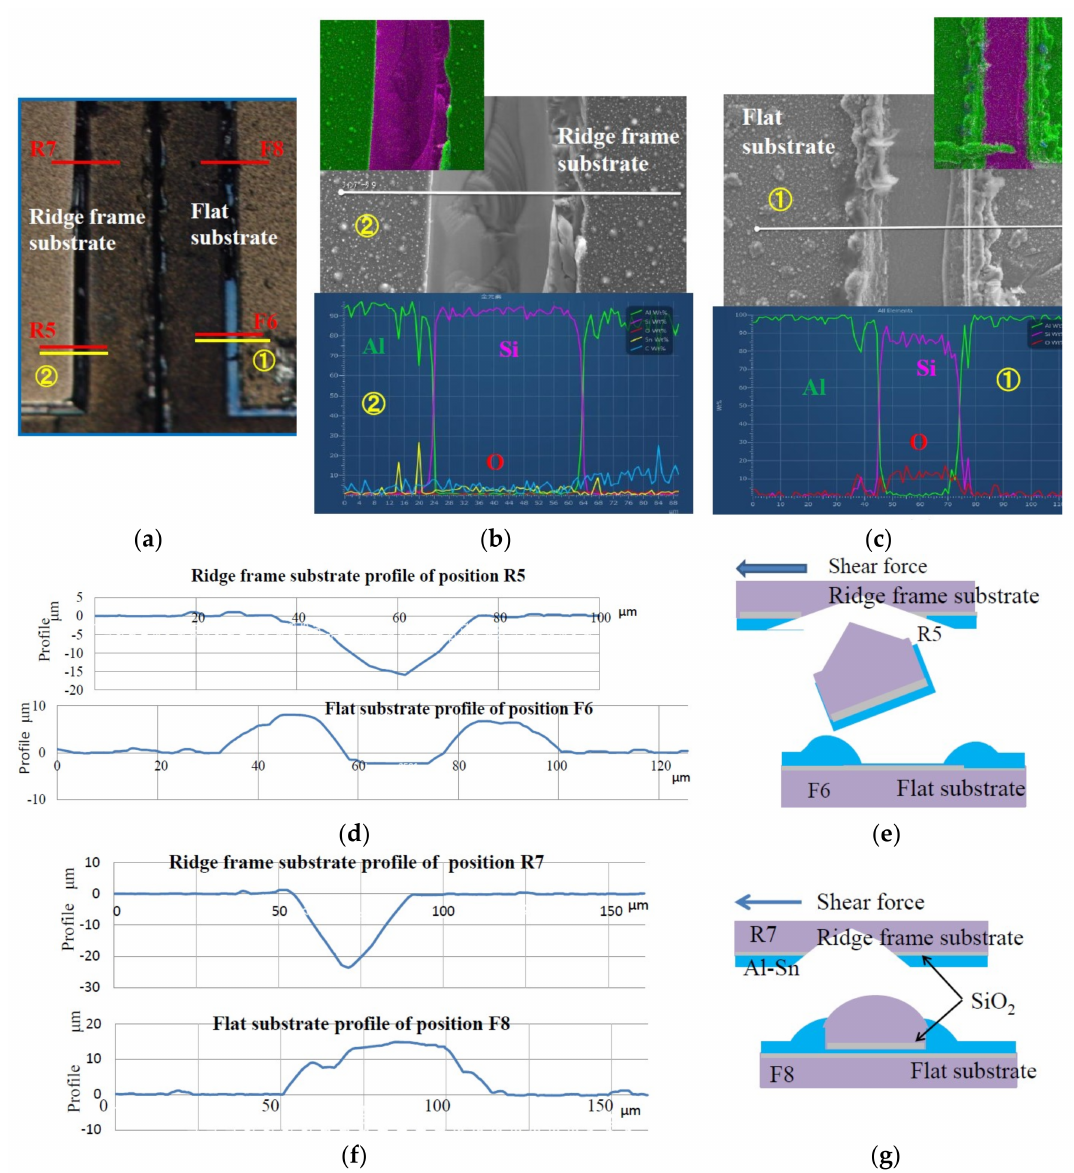
Figure 8. Results of EDX, SEM, and surface profile measurements of shear-fractured die shown in Figure 7. ( a ) Surface photograph of bottom right part of Figure 7a and left part of Figure 7b. ( b ) SEM and EDX observation results of ridge frame substrate and ( c ) of flat substrate. ( d ) Surface profiles of positions R5 and F6; ( e ) Schematically depicted shear fracture cross section around position R5 and F6; ( f) Surface profiles of positions R7 and F8; ( g) Schematic cross section of shear-fractured positions R7 and